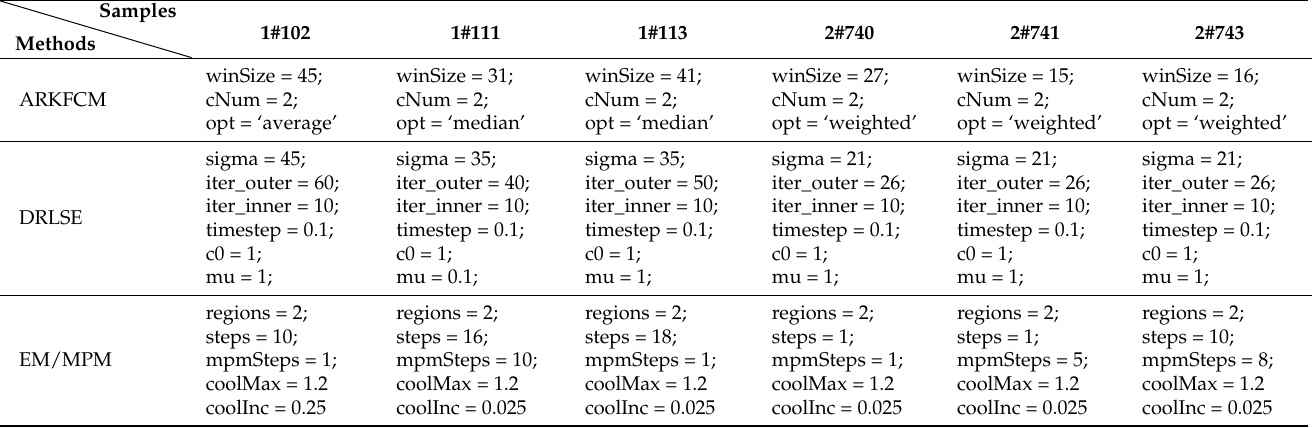
Table 1. Parameters of the comparing